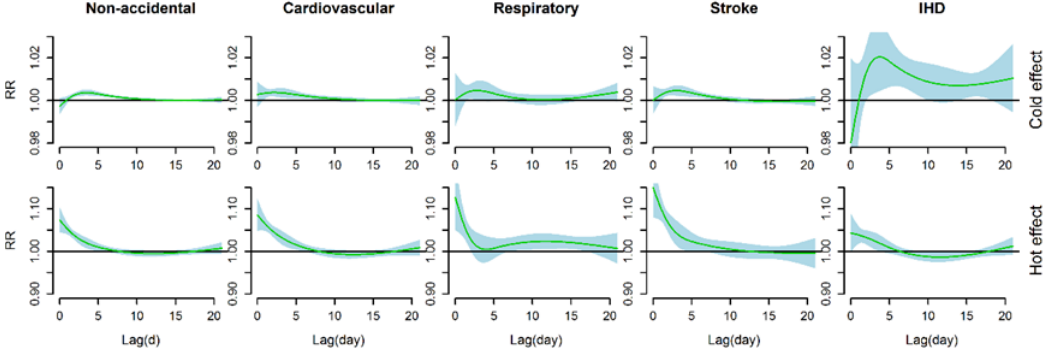
Figure 3. The estimated effects of a 1 °C decrease in mean temperature below the cold threshold